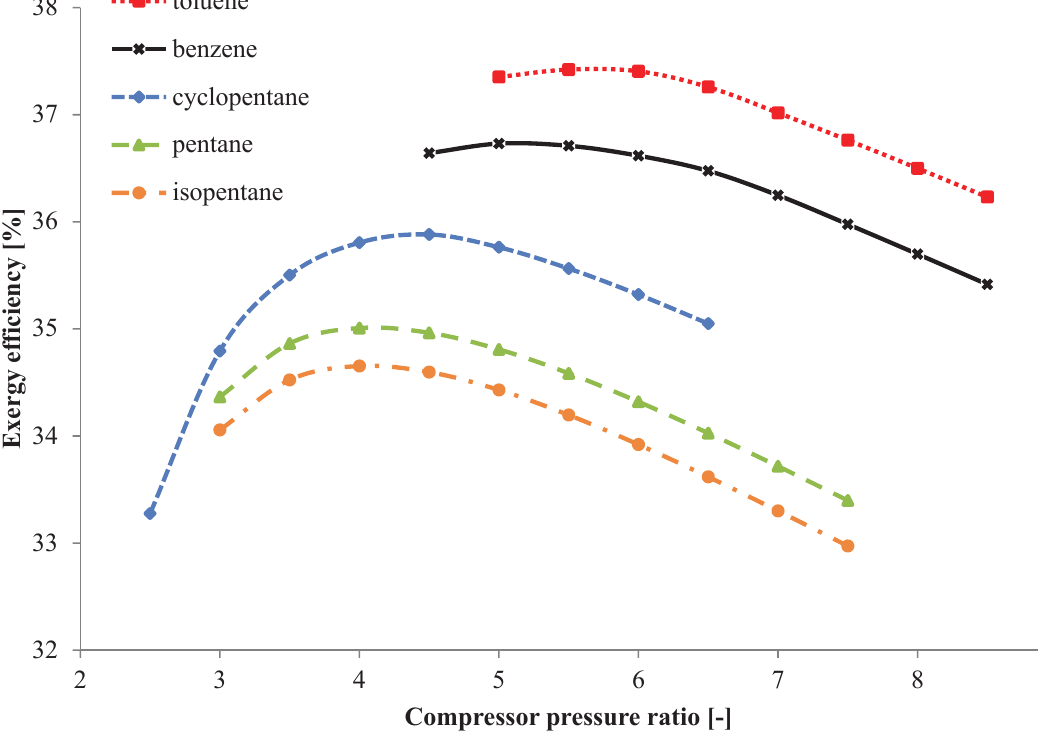
Figure 3. Exergy efficiency of the plant as a function of the compressor pressure ratio for the five working fluid candidates. The turbine inlet pressure of the ORC unit is equal to 20